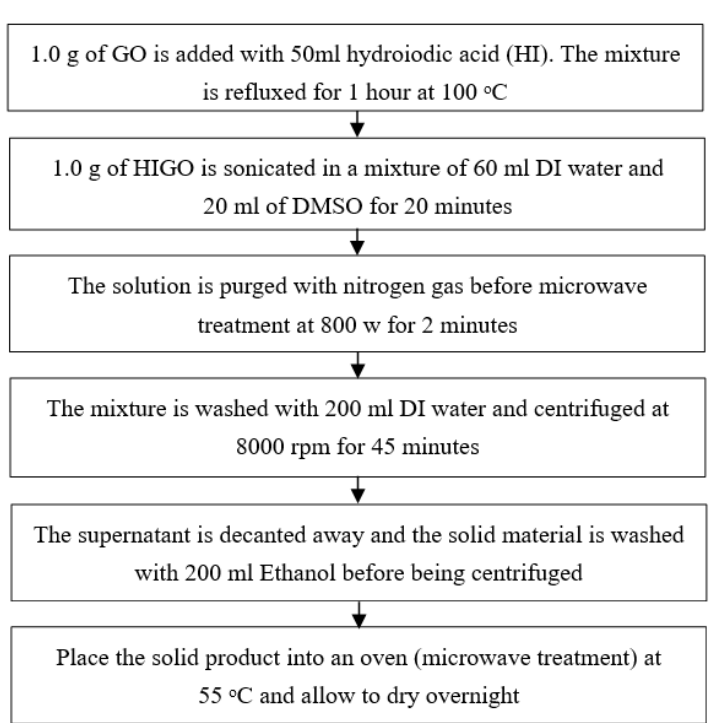
Figure 2. Reduced Oxide synthesizing using an alternative method of chemical and microwave combination for the reduction process.